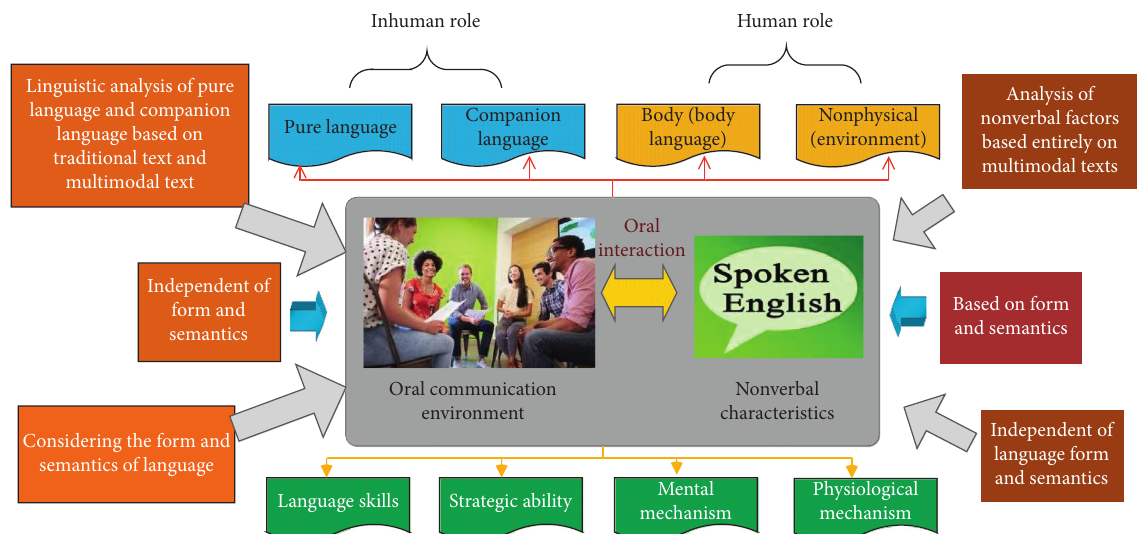
Figure 1: The initial model of the study of oral communicative competence from a multimodal